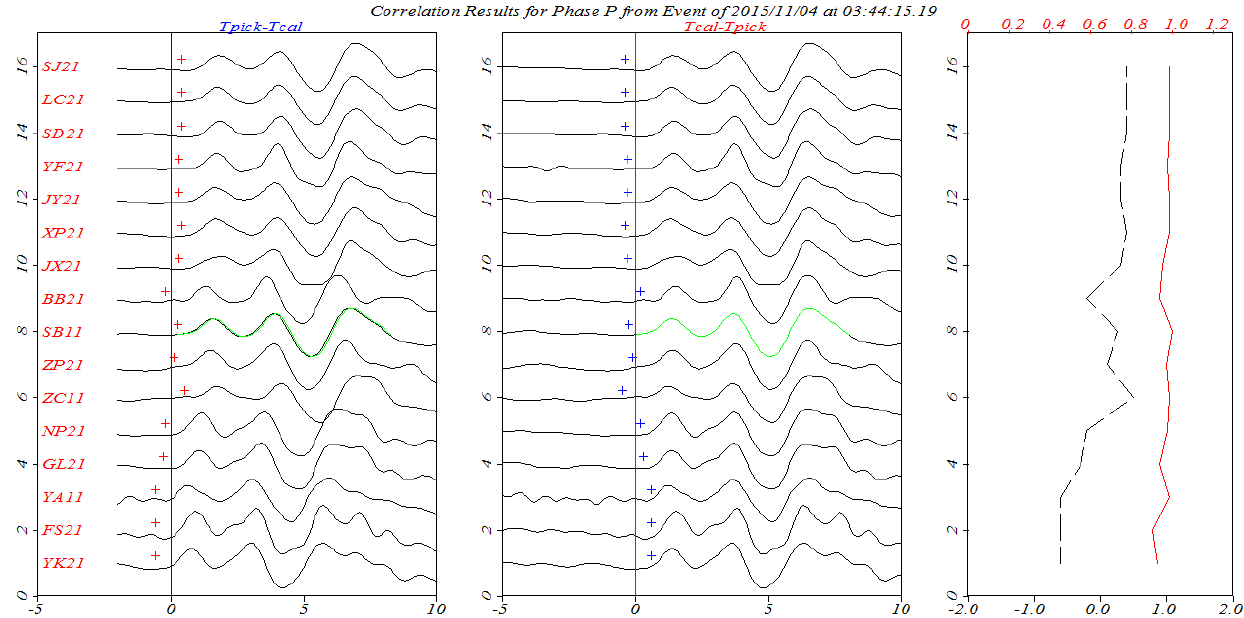
Figure 9. Cross-correlation evaluation system of seismic records in the Alo Islands. (The ( left ) figure shows the waveform with the theoretical arrival time of 0 line; the ( middle ) figure shows the waveform with the measured arrival time of 0 line; the red solid line in the ( right ) figure shows the correlation coefficient. The coordinate axis is the upper red coordinate, the black dashed line is the relative travel time residual, and the coordinate axis is the lower black coordinate in seconds; the station SB11 is selected as the reference wavelet, and its correlation coefficient is 1).